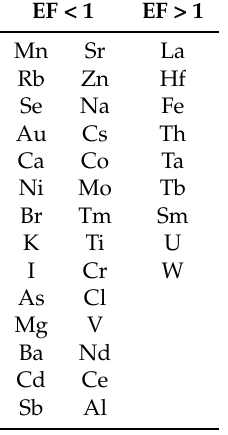
Table 6. Classification of elements according to the degree of contamination.